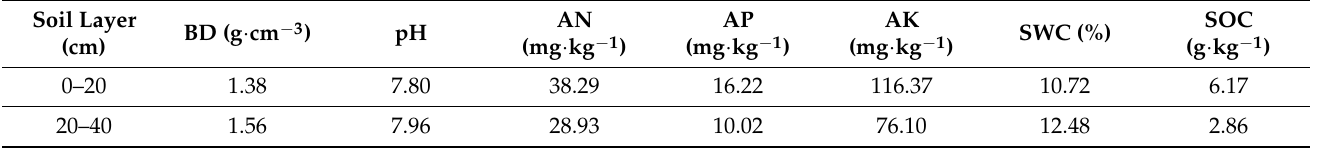
Table 1. Basic physicochemical properties of soil in 2016.